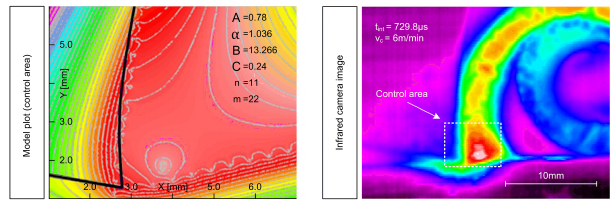
Figure 3. Vortex locations and metal cutting process.